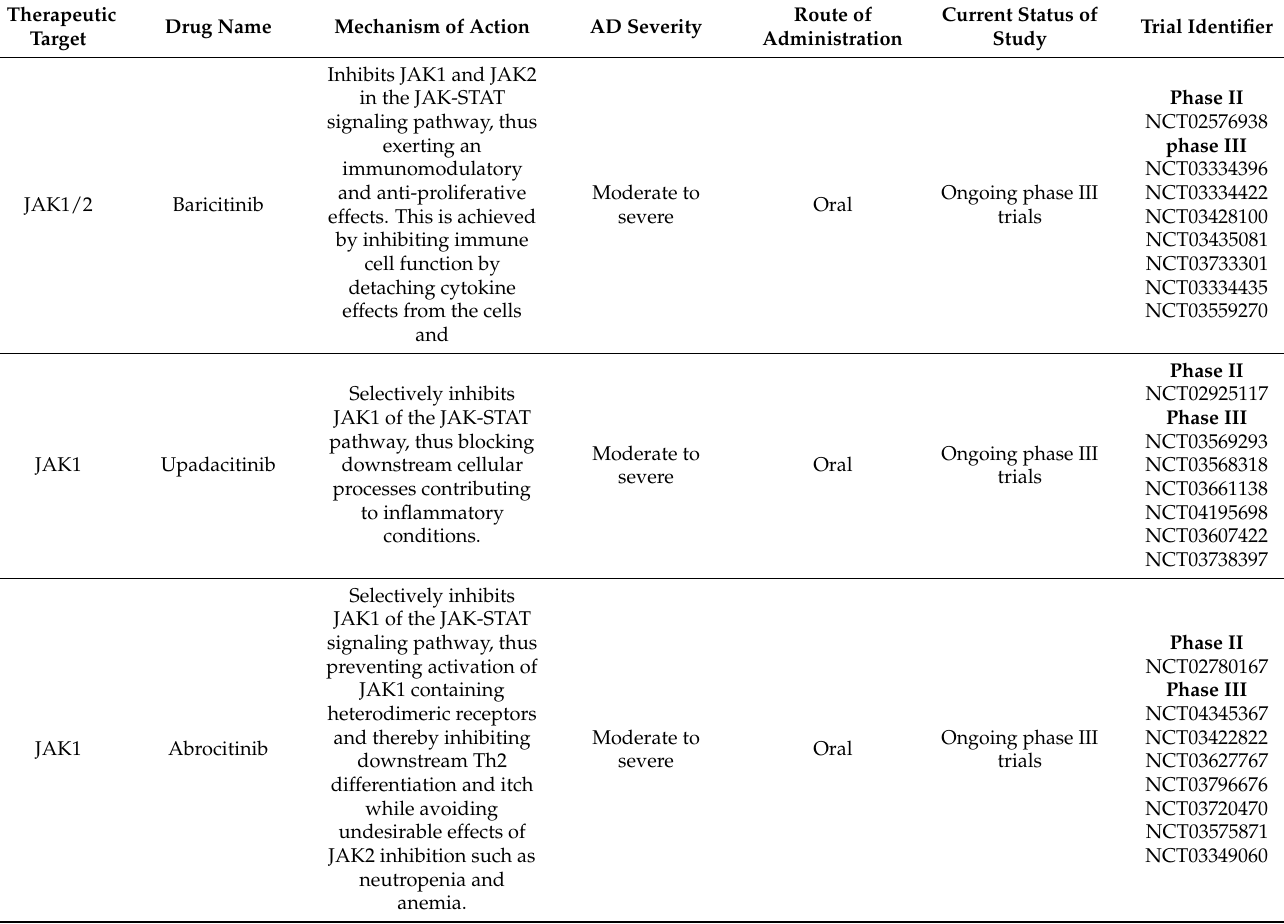
Table 2. Emerging systemic therapeutic small molecules (pathway inhibitors) for